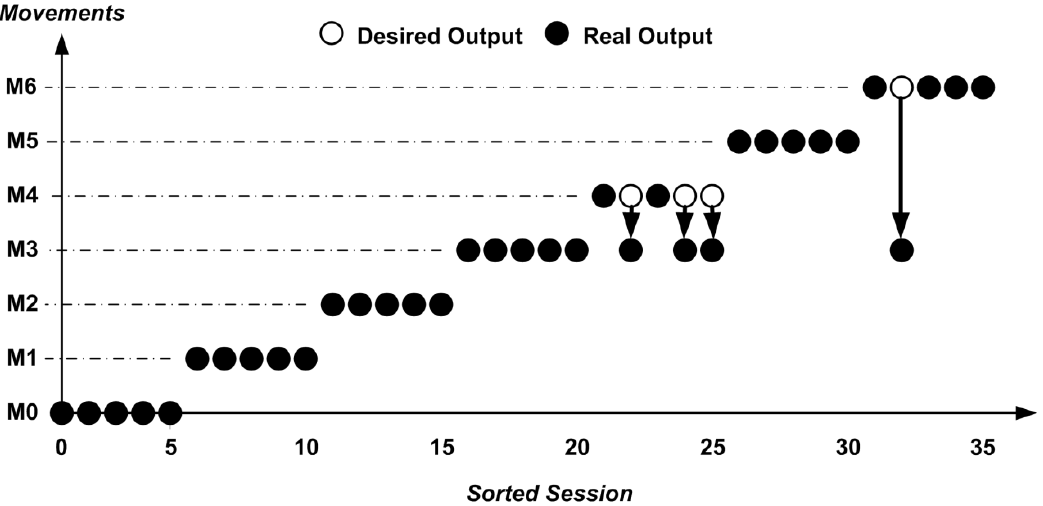
Figure 8. System output for Subject 27–Section 2 (5